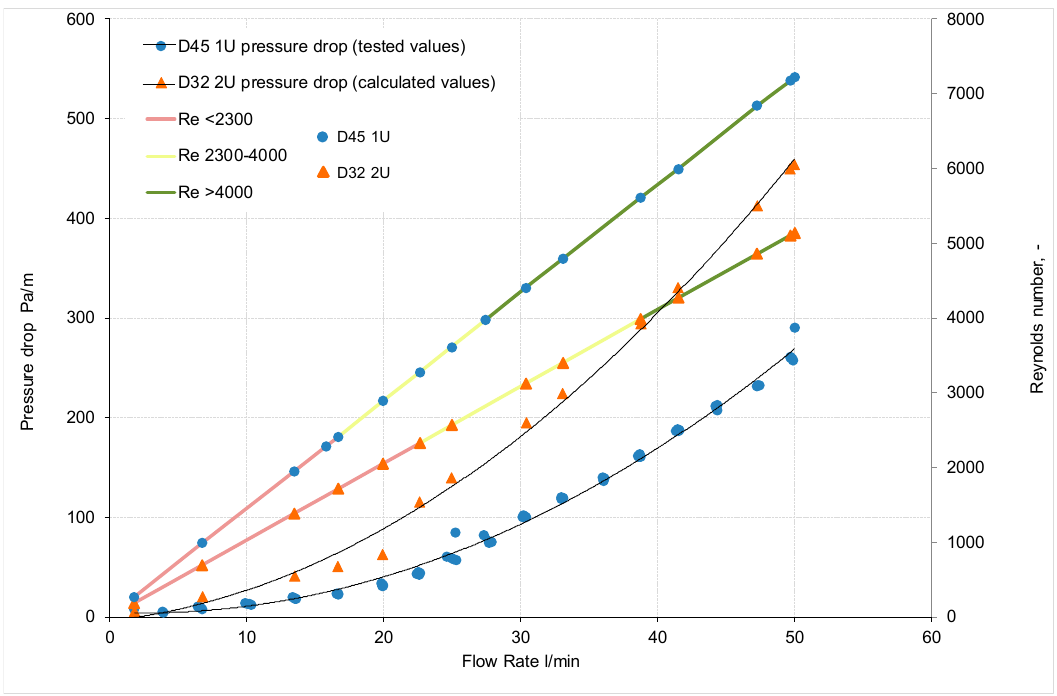
Figure 9. Hydraulic comparison of 2U D32 and 1U D45 TurboCollector TM heat exchangers.